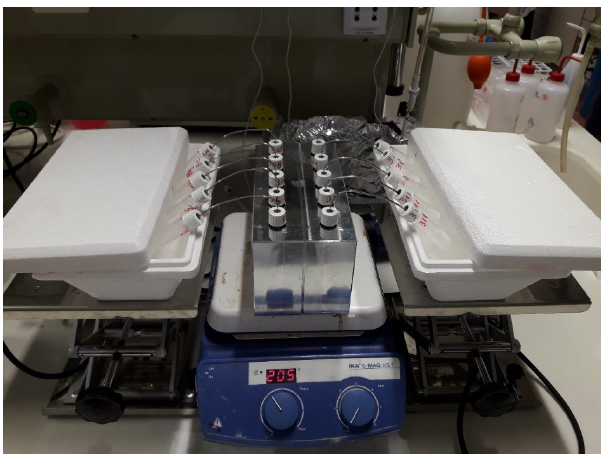
Figure 3. The cryogenic vacuum distillation (CVD) system at the Faculty of Science and Technology of the Free University of Bozen- Bolzano, based on the method developed by Koeniger et al. (2011).